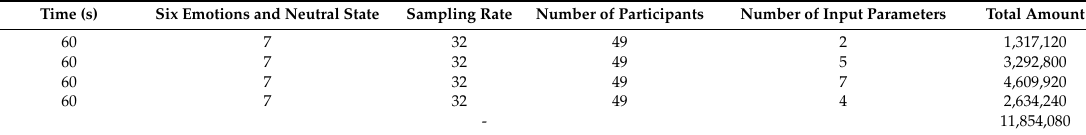
Table 2. Total amount of data used in the study (Units: Data).